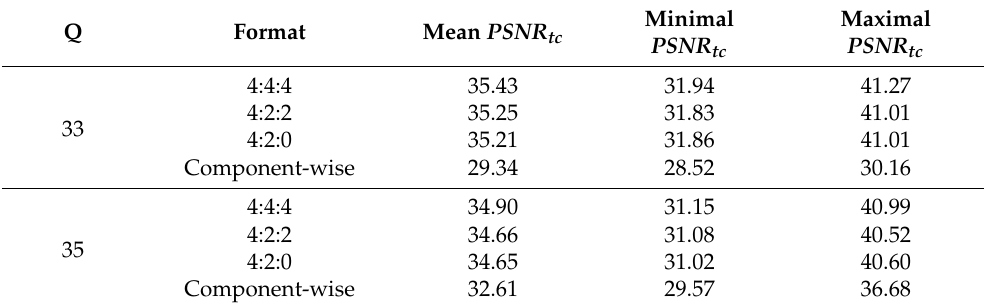
Table 4. Statistical data for comparison of compression variants’ performance characteristics ( PSNR tc ).